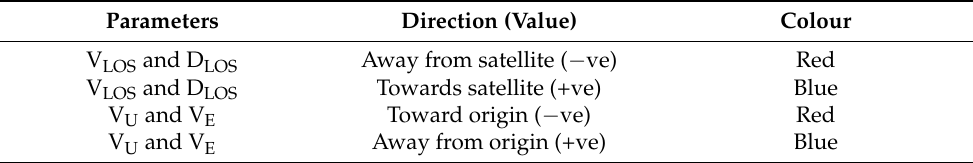
Figure 6. 3D InSAR geometry adapted from Fuhrmann and Garthwaite [42]. Sentinel 1 always looks to the right. Sign conventions are summarized in Table 3. In relation to Ventnor, the cliff spans east-west, and satellite passes are nearly perpendicular to the cliff. Table 3. Sign conventions used for remote sensing. D denotes displacement measured in mm, and V denotes average velocity in mm a − 1 . Conventions for V U and V E follow those adapted in Fuhrmann and Garthwaite [42]. The subscript LOS denotes in the line of sight, as discussed in Section